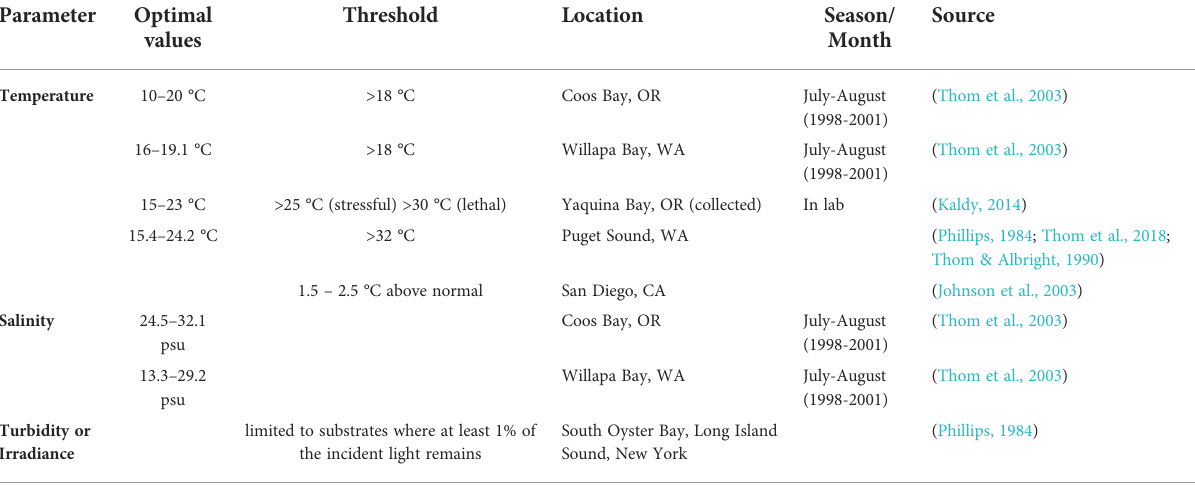
TABLE 2 Temperature, salinity and turbidity optimal physiological values and thresholds for the survival of Zostera marina in the Paci fi c Northwest.